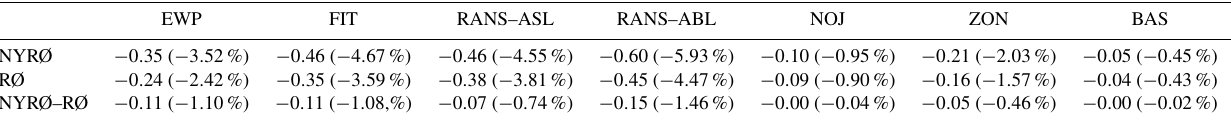
Figure 16. West–east cross section of wind speed deficit with respect to a no-wind-farm (NWF) scenario averaged in the north–south direction over the pink area A2 in Fig. 2 for the f1 filter method. NWF corresponds to RANS and PyWake for the easternmost grid points and to EWP and FIT for the NWF simulation. The arrow indicates the wind direction (WD). Solid lines correspond to the scenario NYRØ, while dotted lines correspond to the scenario RØ. For abbreviations see Tables 5 and 7. Table 8. Wind speed deficit at the closed grid point (for PyWake and PyWakeEllipSys) and interpolated (for WRF) for each model to 10km east of Rødsand II (dashed grey line in Fig. 16) for the different wake models. All results are averaged in the north–south direction over the pink area A2 in Fig.